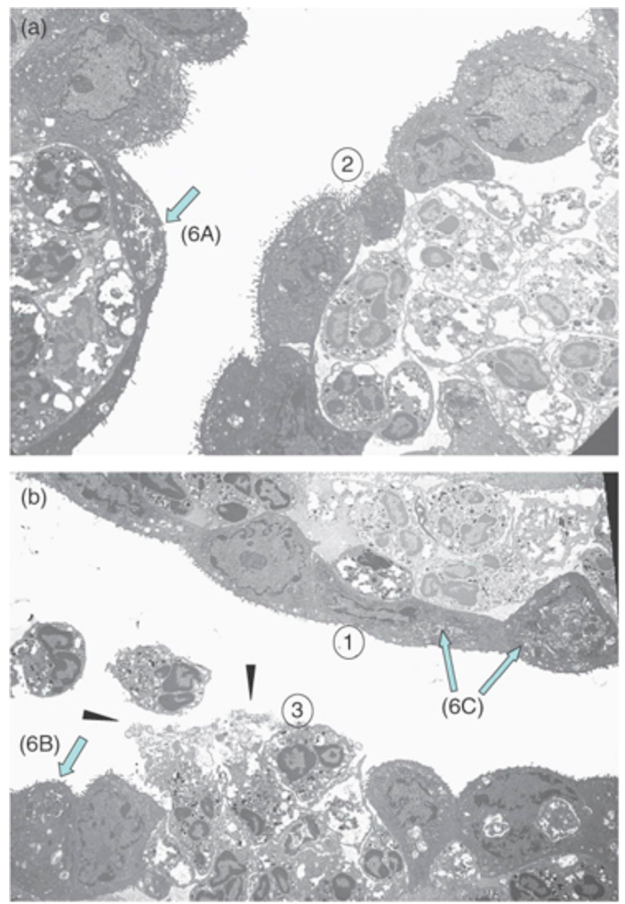
Figure 3. Stages of the PMN response to conjunctival epithelial cells infected by chlamydiae. ( A–B ) (1) PMNs accumulating immediately behind a barrier of infected epithelial cells (arrows). (2) The epithelium loses integrity. (3) PMNs break through the barrier and are released onto the surface, resulting in the release of damaged epithelial cells (arrowheads). The figure is reproduced from Rank et al. [56] with the permission of Oxford University Press.